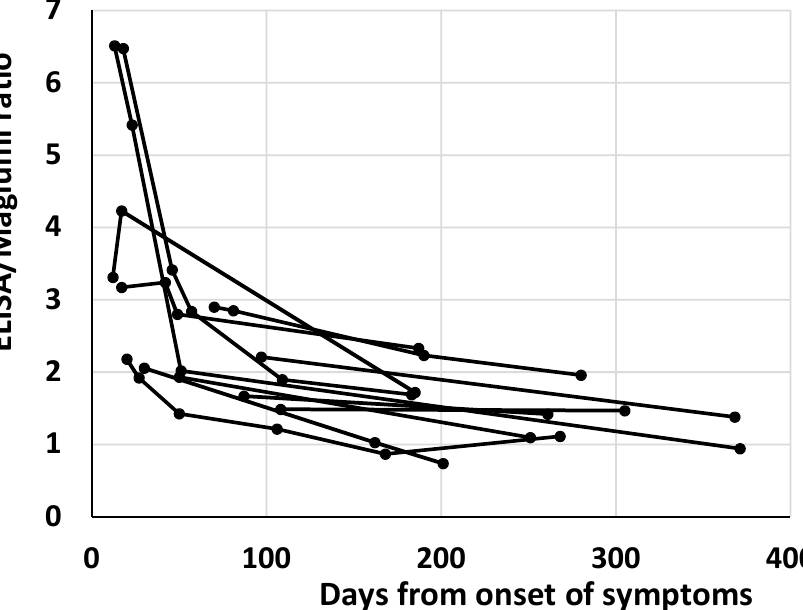
Figure 2. Plot of the antibody ratios between ELISA and Maglumi vs. the days from the onset of symptoms in the 12 patients with more than one sample and at least one sample over 6 months after the symptoms’ onset. Each patient is represented by a line.